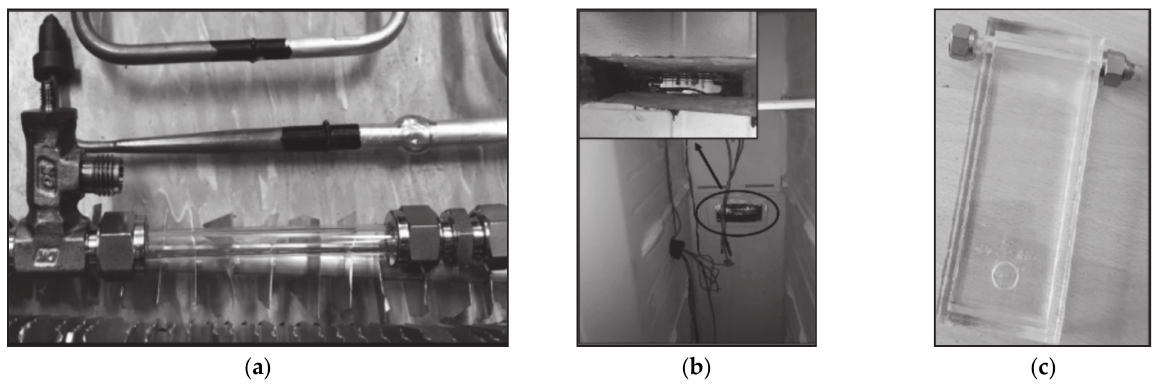
Figure 2. ( a ) Polycarbonate part of the evaporator; ( b ) Visualization hole of the refrigerator; ( c ) Vacuum pump